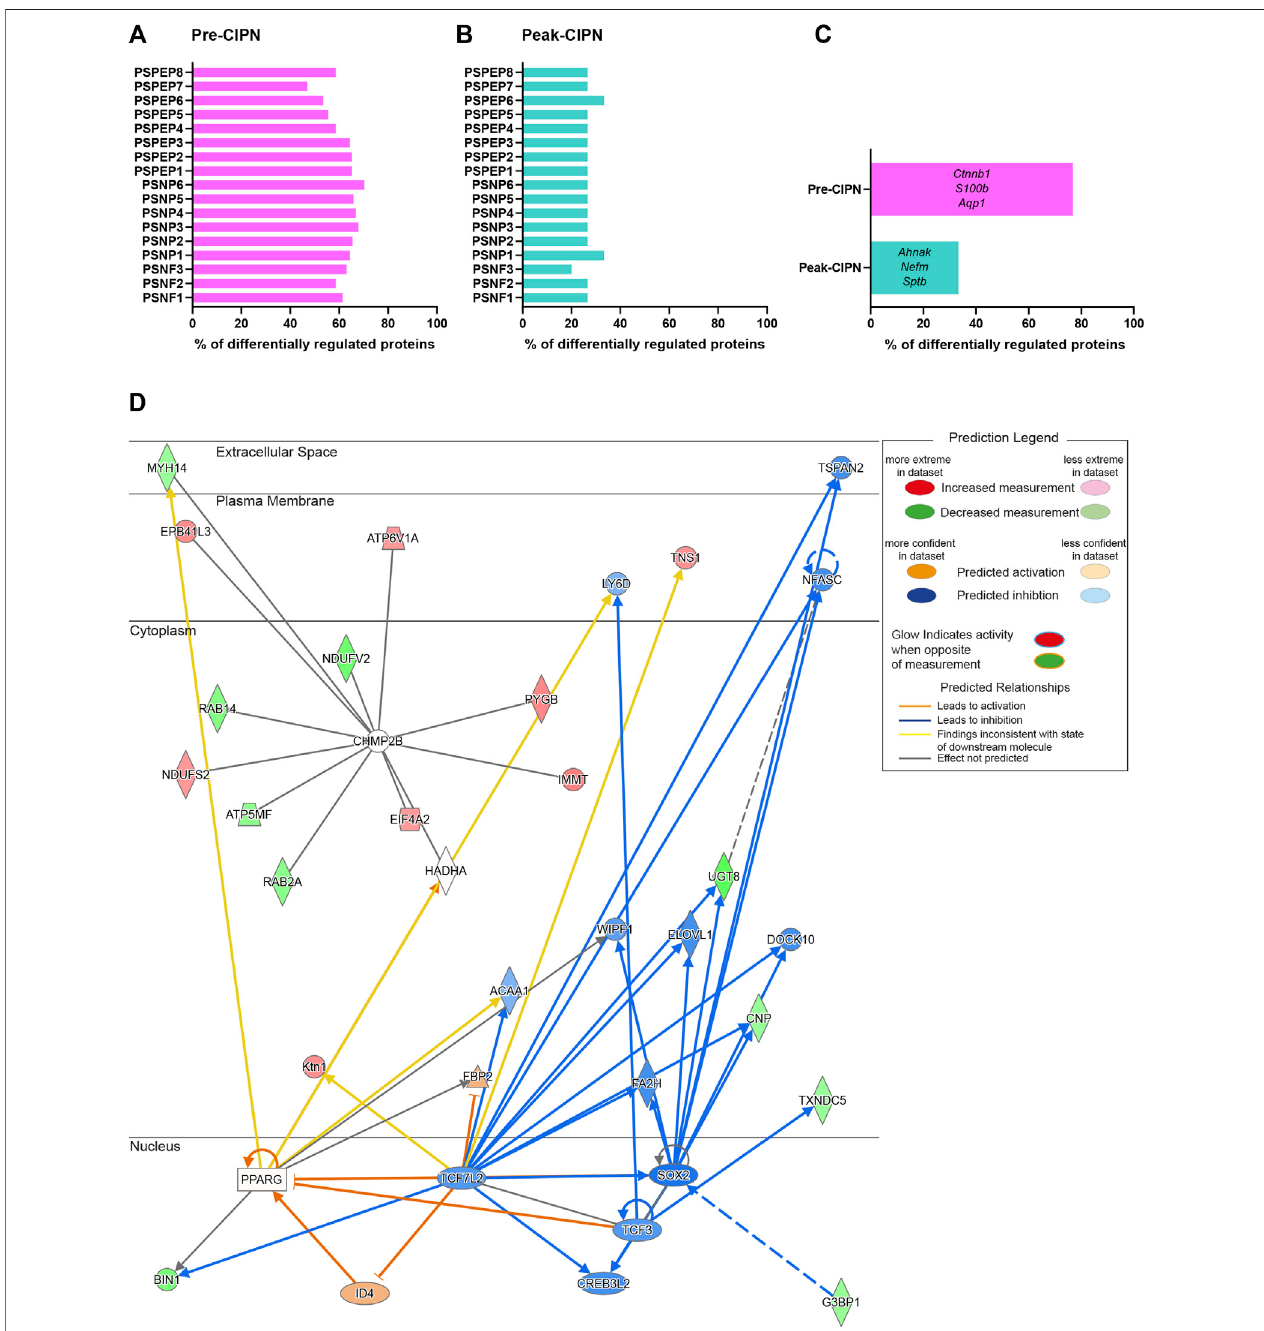
FIGURE4 | Amajor fraction ofdifferentiallyregulated proteins at pre-CIPN isexpressed in sensory neurons. (A/B) Percentage ofdifferentially regulated proteins at pre-CIPN (A) andpeak-CIPN (B) ,forwhichthecorrespondingtranscriptisexpressedinatleast25%ofmousesensoryneuronswithineachsubpopulationaccordingto (Zeiseletal.,2018). (C) Percentageofdifferentiallyregulatedproteinsthatarepresentinatleastoneoftheneuronalsubsets.Examplesaregiven(usinggenenames). (D) Predicted activity analysis (by IPA) of a protein network associated with “ neurological disease ” ( Supplementary Table S5 , Network 7) harbouring regulated proteins at